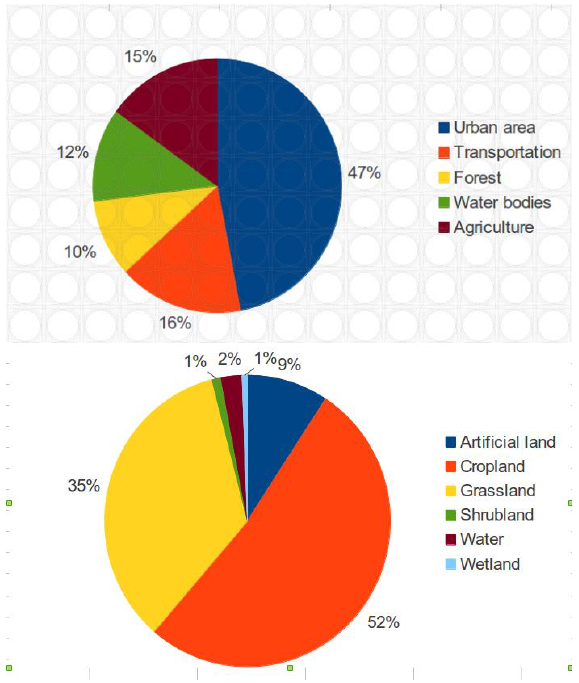
Figure 2: Land Use and Land Cover distribution using TerraSAR- X images and LUCAS over Germany